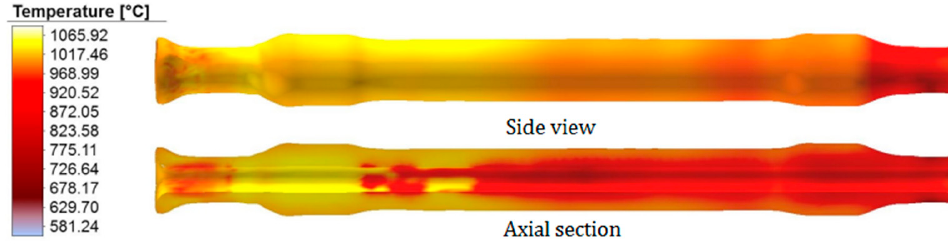
Figure 30. Distribution of effective strain in hollow axle [37] (Reprinted from ref. [37]).